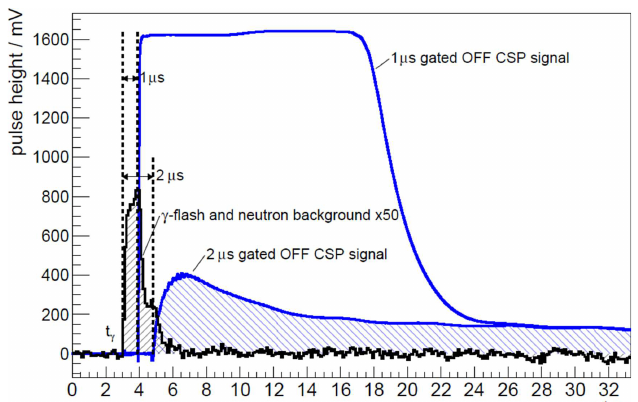
Fig. 3. Averaged Frisch Grid Ionization Chamber (DFGIC) anode signal traces from a detector test at CERN N TOF EAR2. The directly measured detector current (without using a preamplifier) is depicted as black hatched line. It contains the gamma-flash superimposed with neutron-induced background. The γ -flash starts at t = 3 µ s. The charge-sensitive preampli- fier has a short decay shaping time of 3 µ s. The preamplifier signals are shown in blue with two different gate lengths (1 µ s and 2 µ s) for gamma-flash, for gating off the signals by the switch. The 1 µ s gated off preamplifier signal is saturated for about 15 µ s. The 2 µ s gated off preamplifier signal (hatched area) has no more saturation. (Figure courtesy S. Urlass, PhD thesis TU Dresden, 2022).